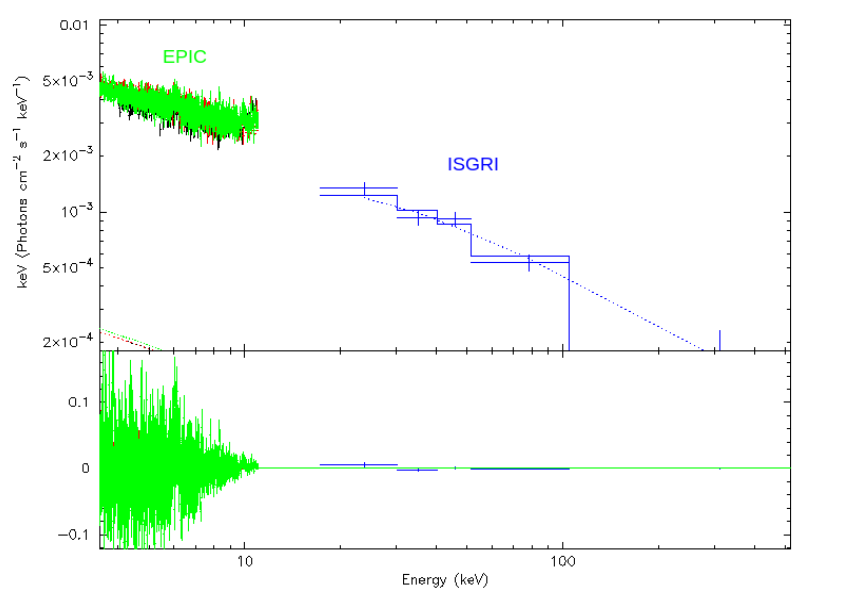
Figure A6. Unfolded XMM-Newton/EPIC (MOS and PN) and INTEGRAL/ISGRI spectra of 3C 111 during 6th observational period and model. Above: all the spectra are shown by crosses; fitting curves are shown by solid lines; model components are shown by dotted lines; below: data residuals. During this period bot primary nuclear continuum and jet base emission were visible; jet component is quasi two times brighter in 5–7 keV energy range. Weak Fe-K α line was visible, but no signs of absorption features near 5.9